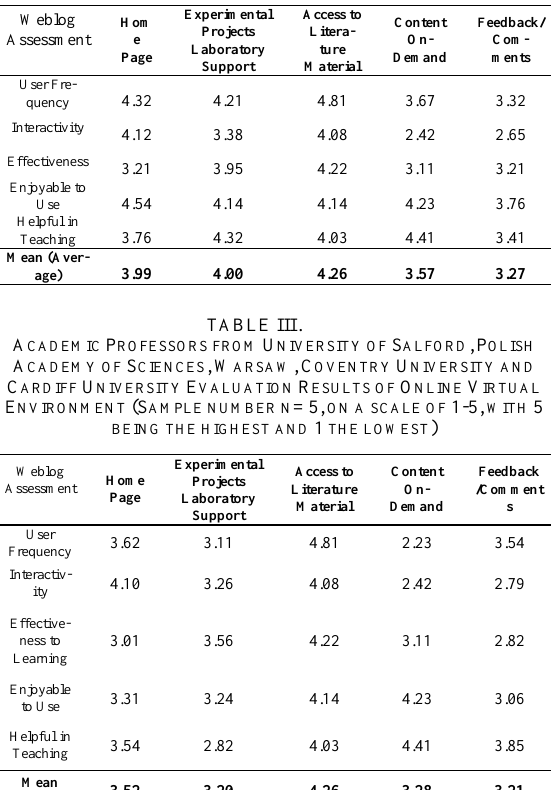
TABLE II. S TUDENT /L EARNERS E VALUATION R ESULTS OF O NLINE V IRTUAL E NVIRONMENT (S AMPLE NUMBER N = 35, ON A SCALE OF 1-5, WITH 5 BEING THE HIGHEST AND 1 THE LOWEST )